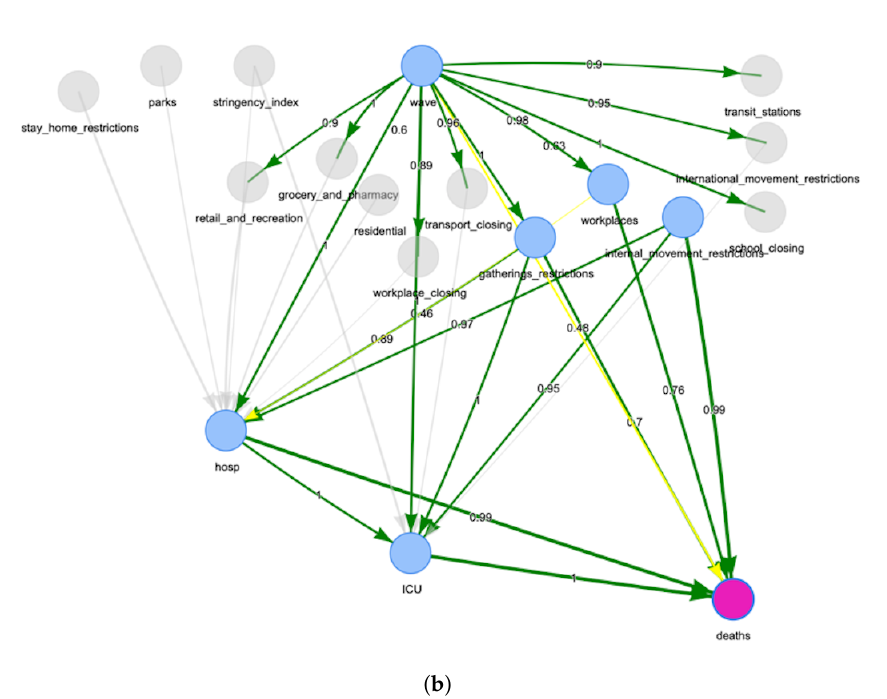
Figure 4. Network for Italy obtained using the bootstrap. ( a ) Overall network for Italy; ( b ) connections to the node “ deaths ” in the network. The figures are downloadable at https://tinyurl.com/rbexhtww (accessed on 26 February